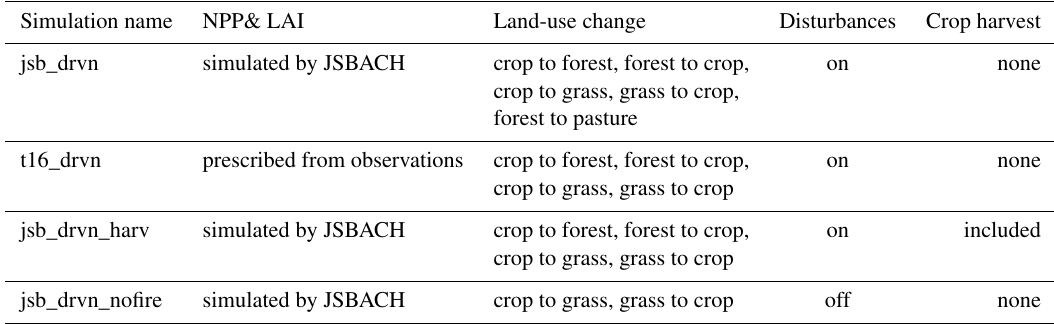
Table 2. Summary of the simulations done in this study.